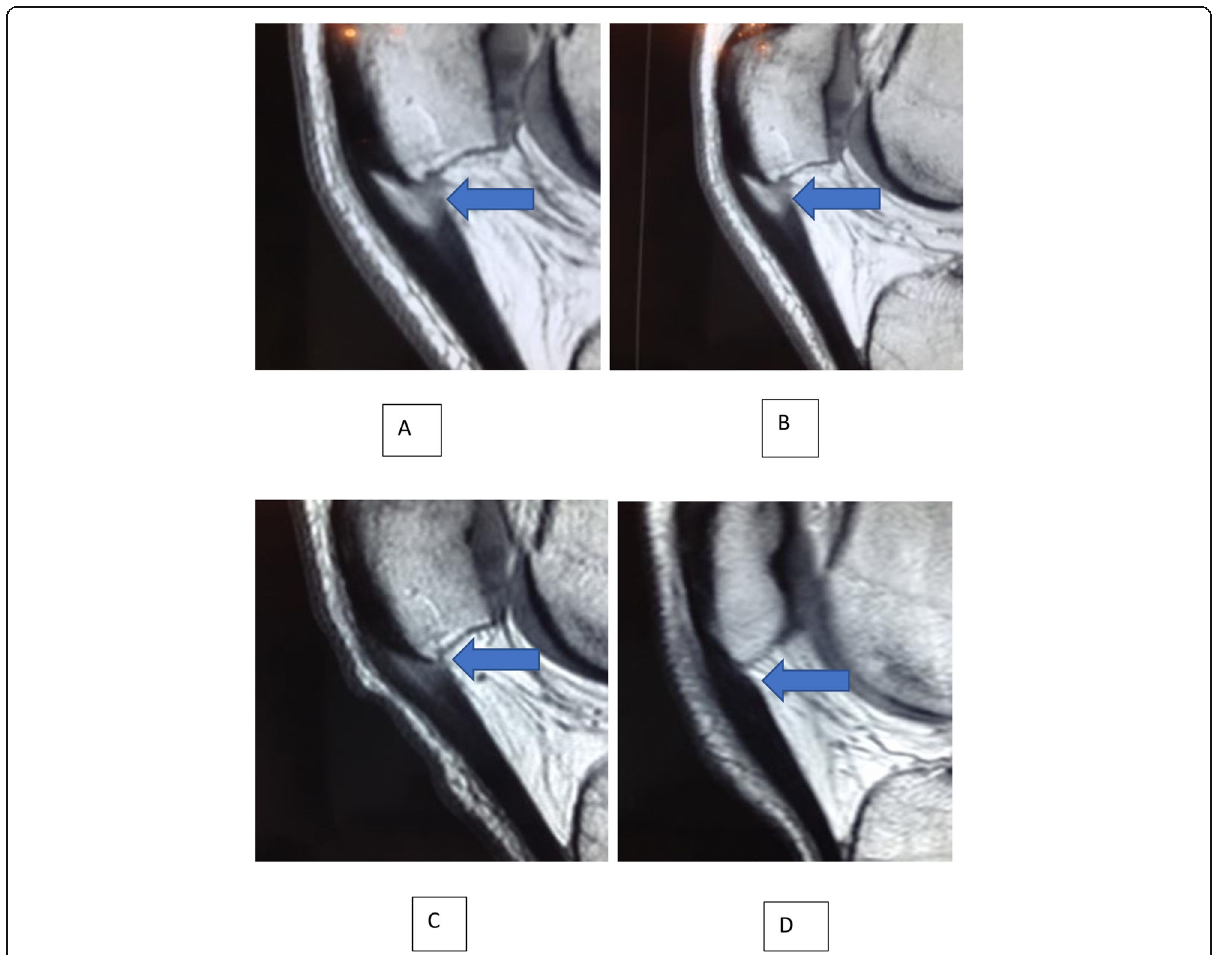
Fig. 9 Sagittal T1 MR images of insertional tendinopathy healing at ( A ) Baseline, ( B ), 3, ( C ), 6, and ( D ), 12 months post-injections. Note the decreasing area of tendinosis\Tear (Blue Arrows). Image D: Only a thickening of the tendon can be